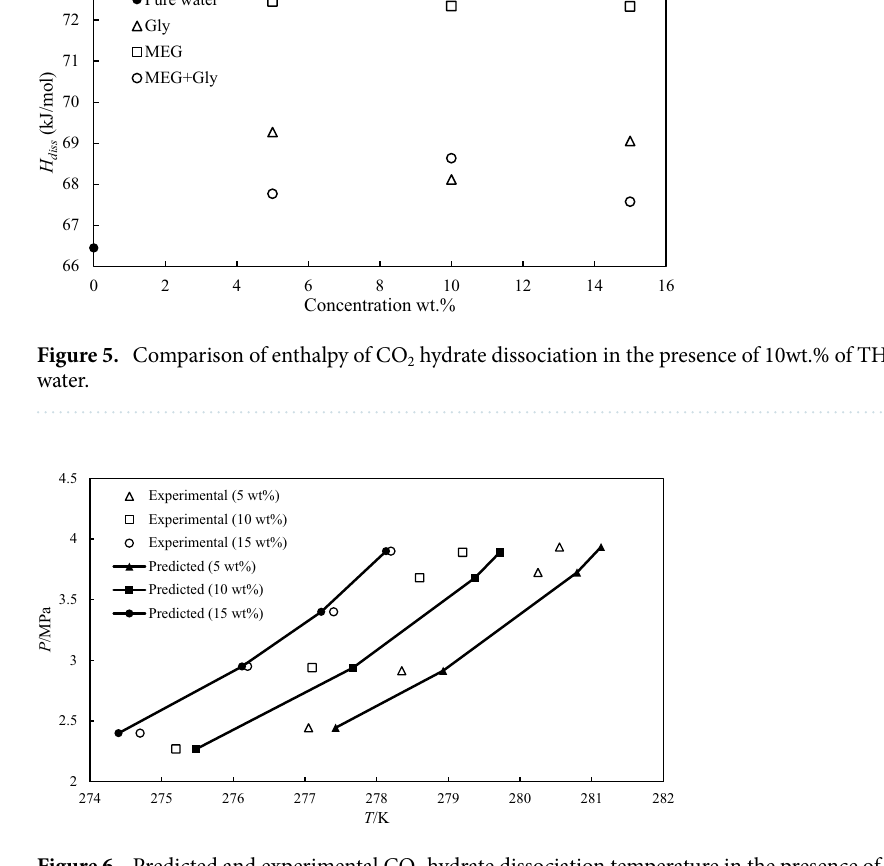
Figure 6. Predicted and experimental CO 2 hydrate dissociation temperature in the presence of 1:1 mixture of MEG + Gly.